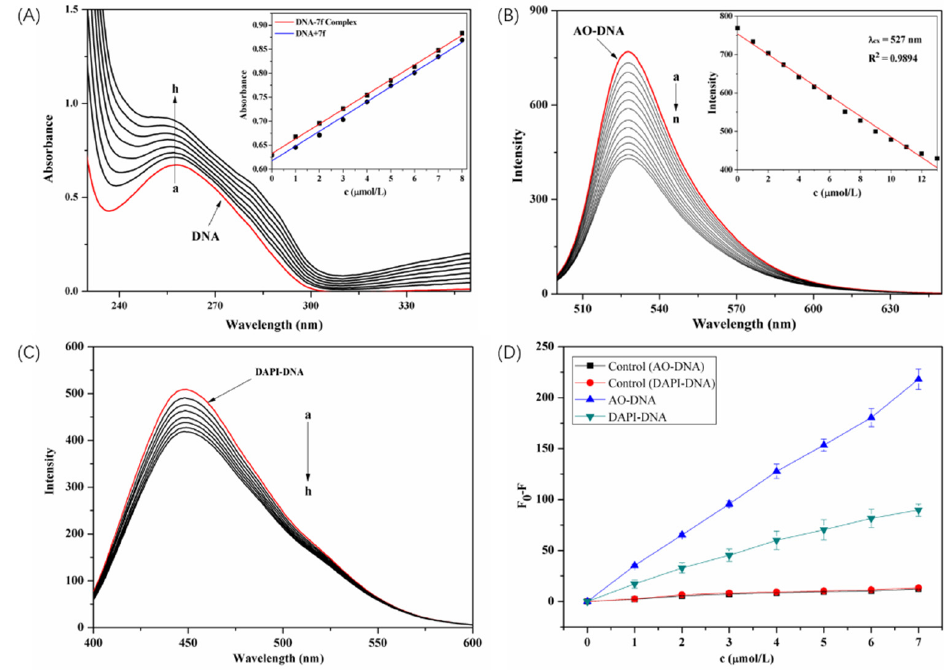
Figure 3. ( A ) Interaction spectra of DNA with different concentrations of thioether benzimidazole 7f (pH = 7.4). c(DNA) = 5.68 × 10 − 5 mol/L, and c(compound 7f ) = 0–0.8 × 10 − 5 mol/L. Inset: Comparison of the absorption at 260 nm between the value of compound 7f -DNA complex and the sum values of free DNA and free compound 7f . ( B , C ) Competitive reaction between compound 7f and AO ( B ), DAPI ( C ) with DNA. c(DNA) = 5 × 10 − 5 mol·L − 1 , c(AO) = 2 × 10 − 5 mol·L − 1 , c(DAPI) = 2 × 10 − 5 mol·L − 1 and c(compound 7f ) = 0–0.7 × 10 − 5 mol·L − 1 . ( D ) The changes of fluorescence intensity for AO-DNA and DAPI-DNA with different concentrations of fluorophore 7f . (F 0 : only AO-DNA or DAPI-DNA, F: 7f with AO-DNA or DAPI-DNA; λ em (AO-DNA) = 537 nm, λ em (DAPI-DNA) = 460 nm).